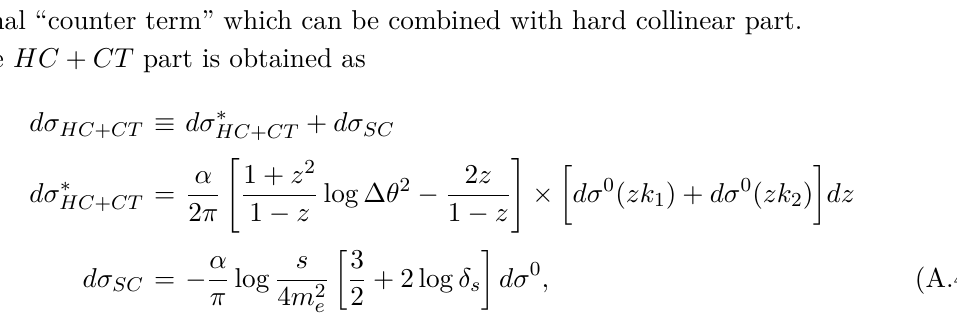
being the regularized Altarelli-Parisi splitting function. The 2nd term in eq. (A.2) gives an additional “counter term” which can be combined with hard collinear